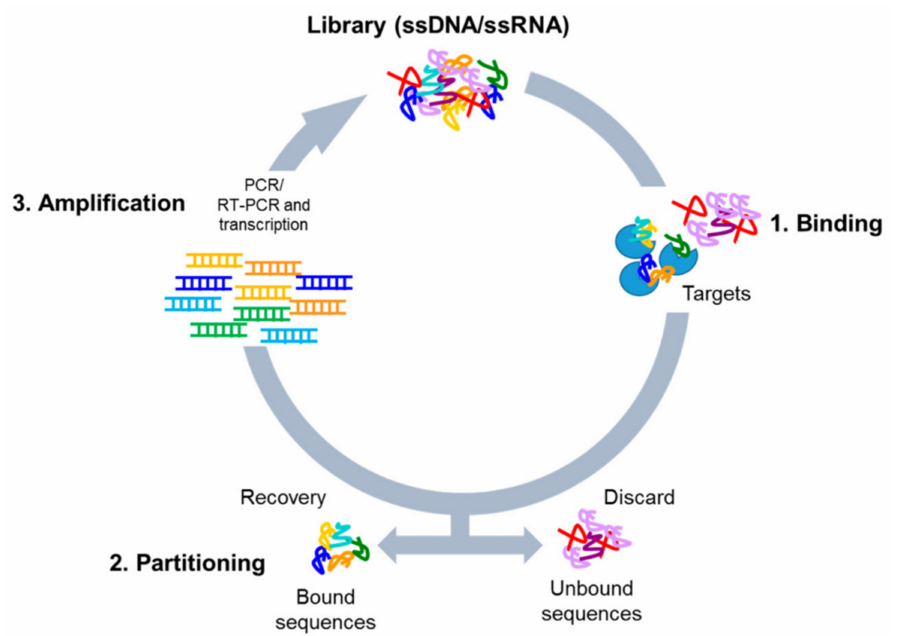
Figure 1. Scheme of the SELEX process [26]. The procedure involves repeated cycles of (1) incubation of the high-complexity library with the targets (binding); (2) removal of unbound sequences and recovery of the bound oligonucleotides (partitioning); (3) amplification of the bound sequences by PCR (for DNA library) or RT-PCR and transcription (for RNA library). (Reproduced with copyright permissions from 10.1002/anie.201001736 accessed on 3 June 2021).